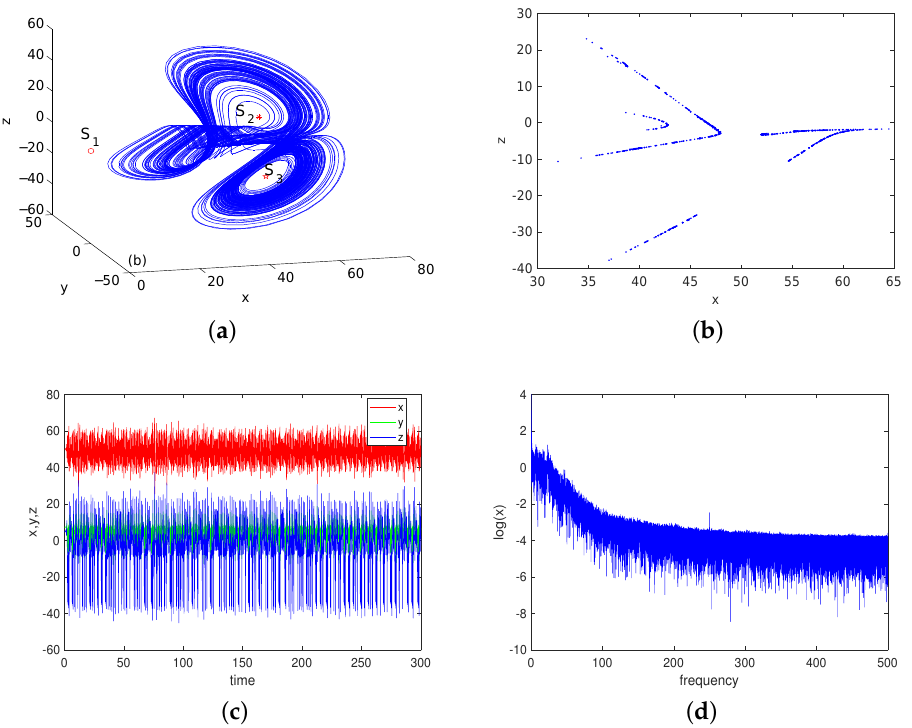
Figure 2. ( a ) Chaotic attractor of system (1) with ( a , b , c , d ) = ( 5,50, − 6,13 ) at the initial values ( 50.01,7.31,5.01 ) T . ( b ) The corresponding Poincaré map on plane y = 5. ( c ) The time series of the x , y , z states. ( d ) The power spectrum of the x